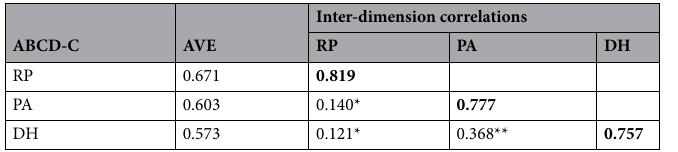
Table 3. Convergent and discriminant validity analysis. AVE, average variance extracted; ABCD-C, Chinese version of Attitudes and Beliefs about Cardiovascular Disease (ABCD) Risk Perception Questionnaire; RP, risk perception; PA, perceived benefits and intention to change physical activity; DH, perceived benefits and intention to change dietary habits. Bold characters show the square of root of average variance extracted values. * p < 0.05, ** p < 0.001.